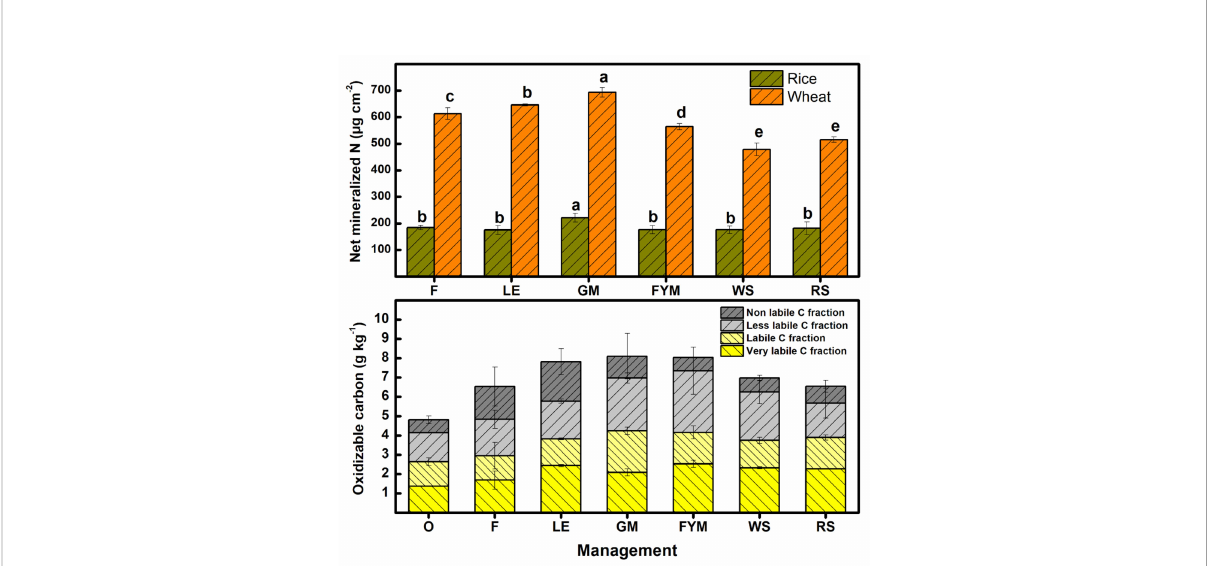
FIGURE 7 Effect of different nutrient management on net mineralized nitrogen during three full seasons of rice and wheat (2017-20), and the changes in soil carbon fractions. Error bars denote ± 1SD. Different letters indicate signi fi cant differences (P ≤ 0.05). Refer to Figure 2 for the description of